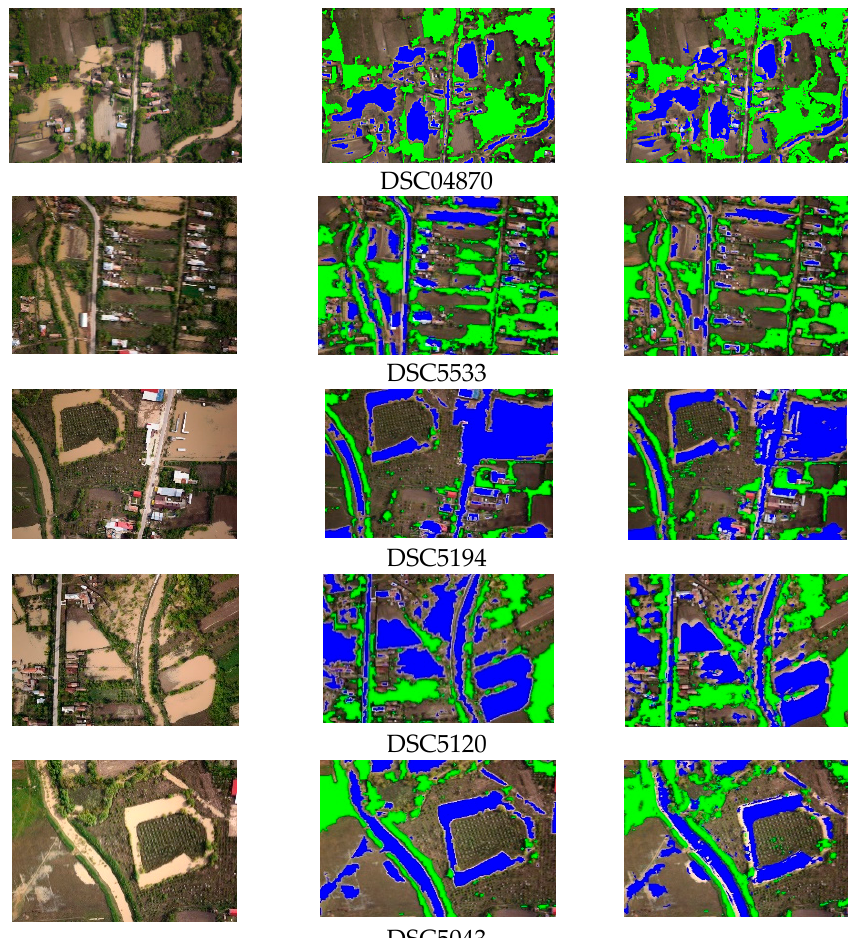
Figure 16. Examples of flood and vegetation segmentation by fusion-based classifier (testing phase)—our dataset.